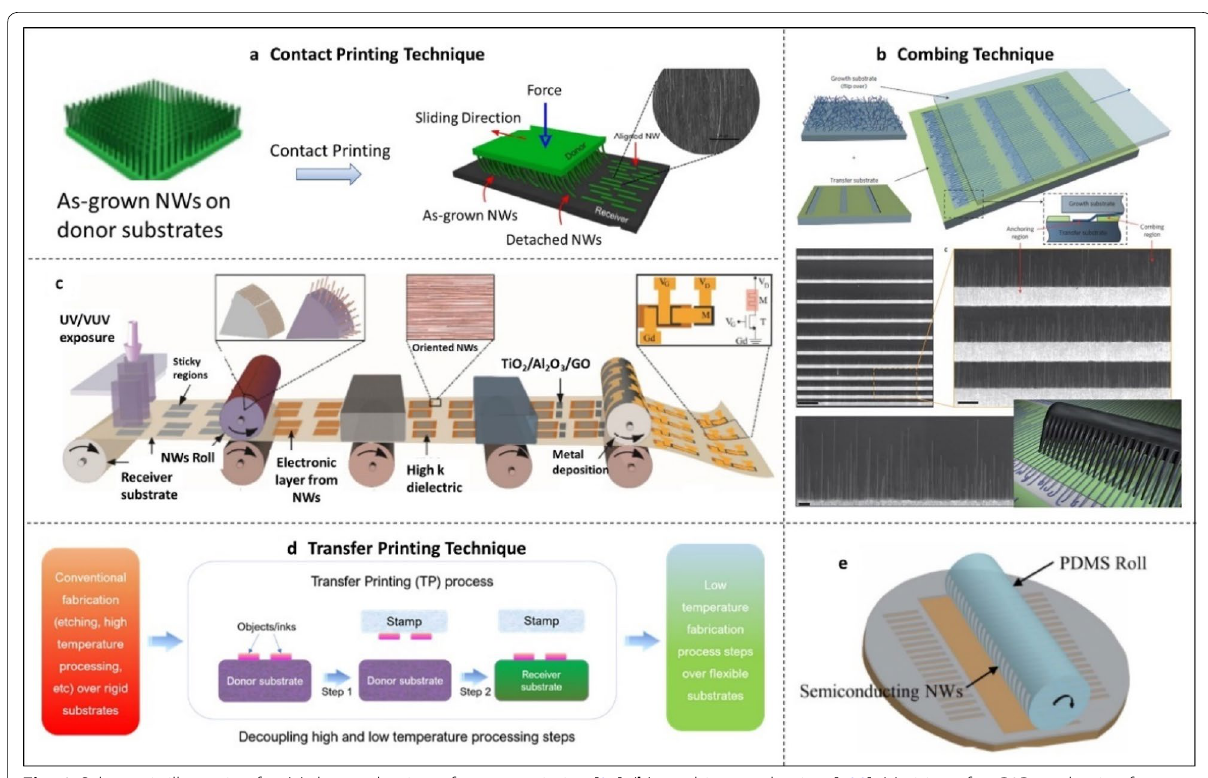
Fig. 6 Schematic illustration for: ( a ) the mechanism of contact printing [25], ( b ) combing mechanism [138], ( c ) vision of an R2R production for NW-based functional circuits on large-area flexible electronics [59], ( d ) mechanism for transfer printing [46]. The figure also shows the overview of transfer printing approach enabling transition from high to room temperature processing steps. e Concept of roll transfer printing